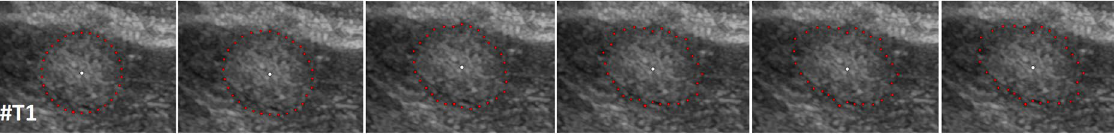
After being satisfied with the segmentation of the first metastasis, the user moved the seed point to the second metastasis on the right. As seen in the screenshots of the video, the resulting segmentation contours (red dots) collapsed, because, in this area, no lesion is present (note: the screenshots present only a fraction of the whole video). When the user reached the second metastasis on the right, the red segmentation contour automatically expanded again and adapted to the metastasis border (lower two images). The lower image presents the final out- lining of the second metastasis, where the user stopped the interactive segmentation process. Moreover, Fig. 10 shows a side-by-side comparison of manual expert measurements (left) and interactive segmentation results (right) for the two liver metastases from Fig. 9. Evaluation of the segmentation algorithm using pancreatic cancer metastases. After the initial setup of the algorithm parameters using liver metastases with predefined echo pattern, we evaluated the algo- rithm using a set of 40 images of 24 patients with pancreatic cancer liver metastases from clinical routine. In total, 37 different metastases have been segmented in random order. Three metastases have been segmented with a dif- ferent image zoom. The selection reflected the general echogenicity distribution of pancreatic cancer metastases, with 31 of the 37 metastases being hypoechoic, 5 isoechoic and one hyperechoic compared to the surrounding liver tissue. The images have not been previously segmented with the proposed algorithm before. Initially, the operator performed a manual segmentation of the metastases and then measured the maximal diameter in a